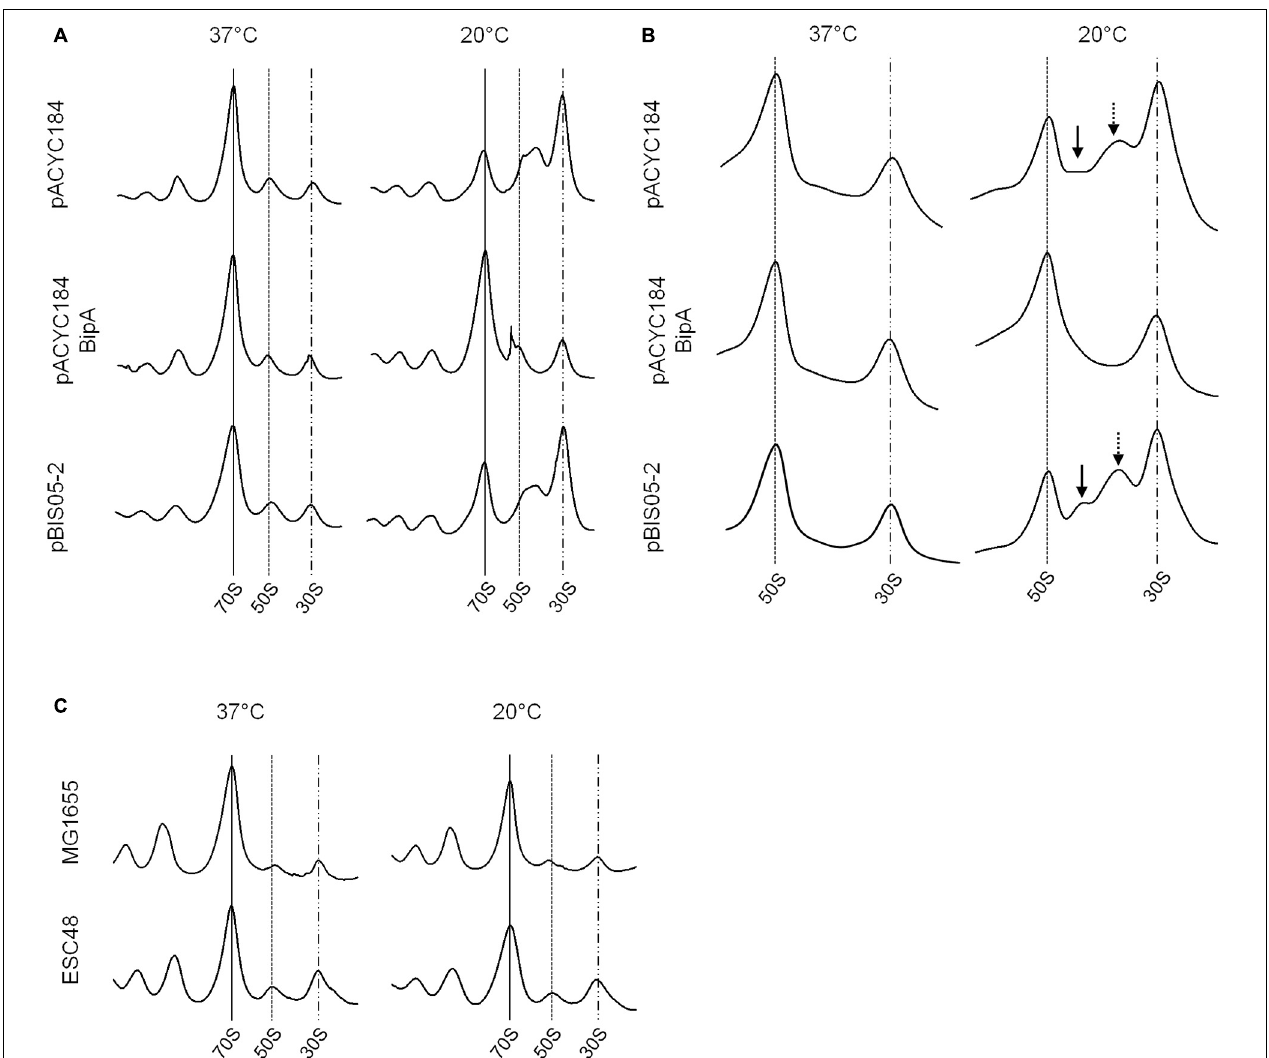
FIGURE 2 | Ribosomal abnormality retained in the suppressor strain. Polysome profiles (A) and subunit profiles (B) of ESC19 cells harboring pACYC184, pACYC184BipA, and pBIS05-2. Transformants were grown at 37 ◦ C or 20 ◦ C in LB medium containing chloramphenicol until they reached an OD 600 of ∼ 0.6. Then, cell lysates were prepared and analyzed as described in section “Materials and Methods.” Arrows indicate abnormal ribosomal particles. (C) Analyses of polysome profiles of the MG1655 and ESC48 strains. The polysomes were analyzed using the lysate of cells grown at 37 ◦ C or 20 ◦ C in LB medium until the exponential phase as in (A)